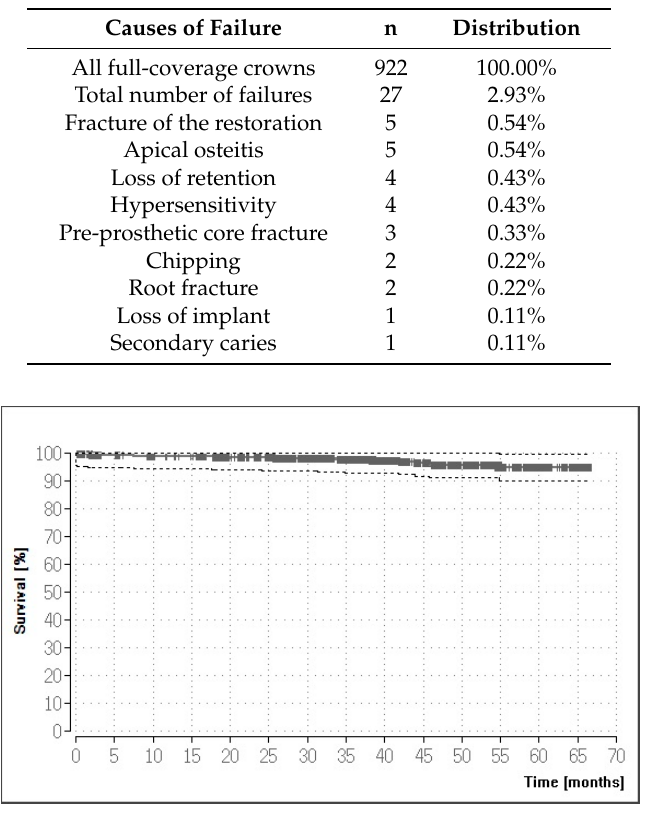
Figure 1. Kaplan–Meier survival curve for crown restorations.